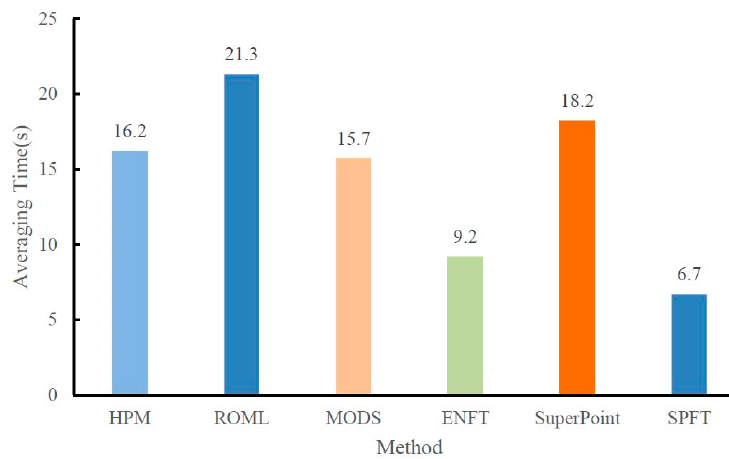
Figure 9. Averaging times for the evaluated methods.